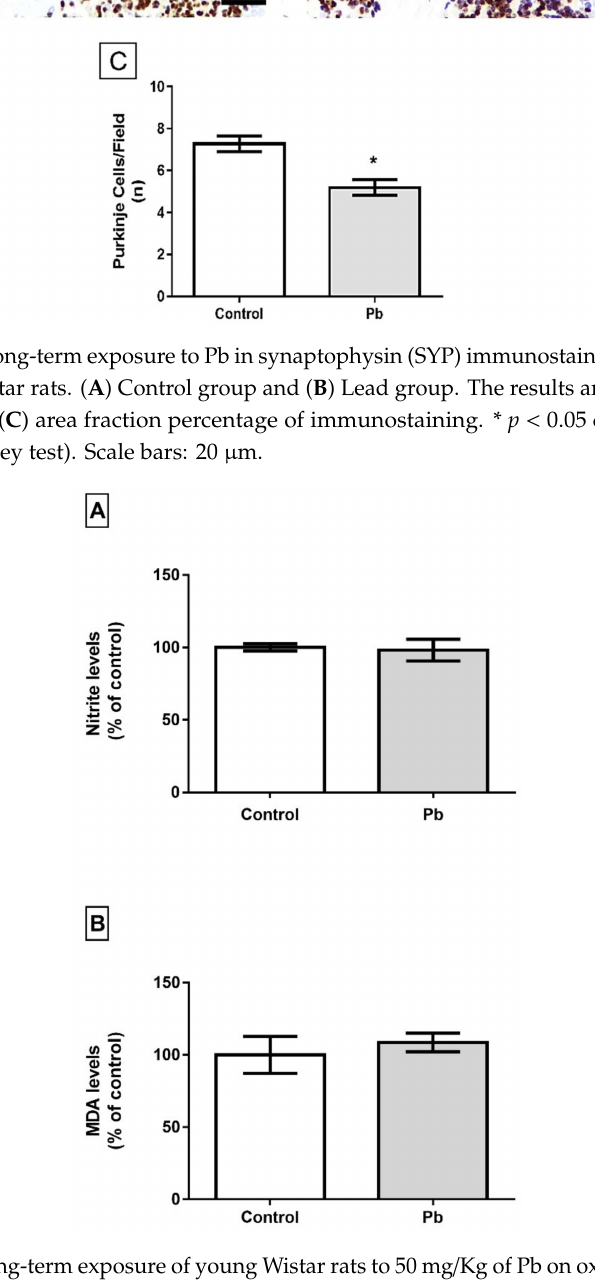
Figure 8. E ff ect of long-term exposure of young Wistar rats to 50 mg / Kg of Pb on oxidative biochemistry in cerebellum. In ( A ) nitrite levels, ( B ) MDA levels. The results are expressed as mean ± standard error after Student’s t-test